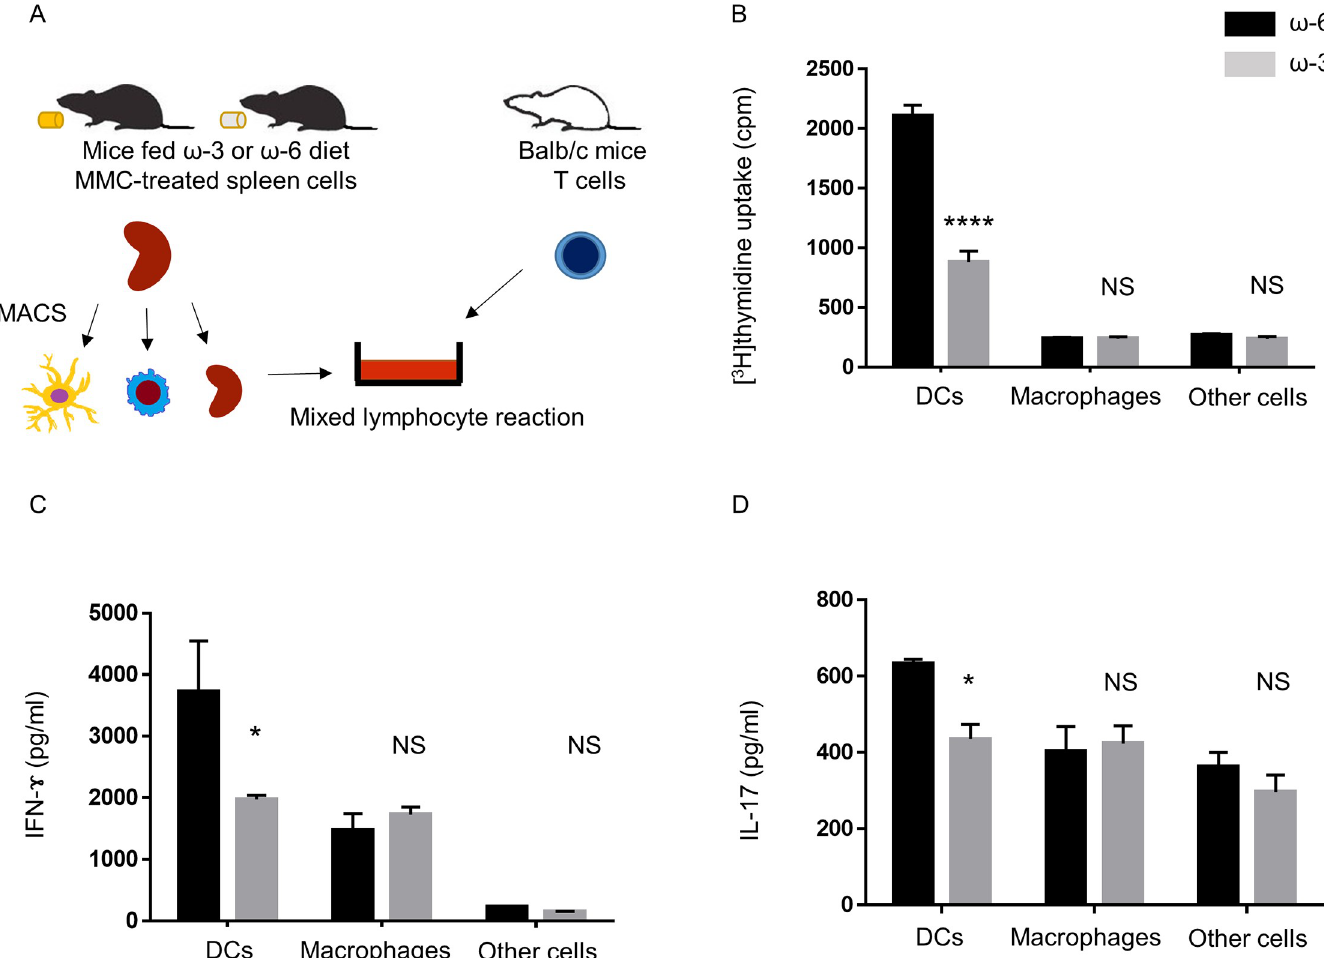
Fig 5. Effects of DCs from mice fed an ω -3 LCPUFA diet on T cell proliferation and cytokine production in an MLR. (A) Experimental scheme. Mitomycin C– treated spleen cells isolated and separately pooled from C57BL/6 mice fed a diet supplemented with ω -3 ( n = 5) or ω -6 ( n = 5) LCPUFAs were fractionated into DCs, macrophages, and other cells. Each of these cell fractions (3 × 10 4 cells) was then incubated for 48 h with CD4 + T cells (3 × 10 5 ) isolated and pooled from Balb/c mice ( n = 5). (B) The proliferation of the T cells was then assessed by measurement of [ 3 H]thymidine incorporation. (C, D) The concentrations of IFN- γ (C) and IL-17 (D) in the coculture supernatants were measured with ELISAs. Data are means + SEM from three independent experiments. � P < 0.05, ���� P < 0.0001, NS versus the corresponding value for the ω -6 LCPUFA diet (Sidak’s multiple comparison